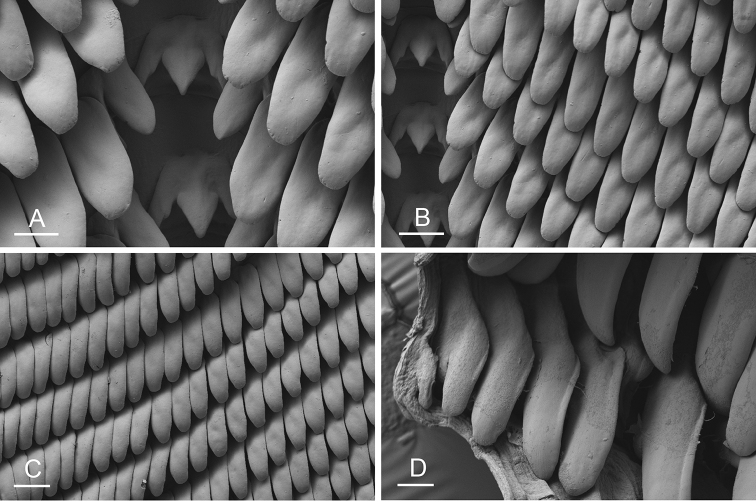
Radula, Peronia
griffithsi, Indonesia, Kei Islands, [3566] (UMIZ 00177) A rachidian and innermost lateral teeth B rachidian and lateral teeth C lateral teeth D outermost lateral teeth. Scale bars: 20 μm (A), 30 μm (B), 40 μm (C), 10 μm (D).